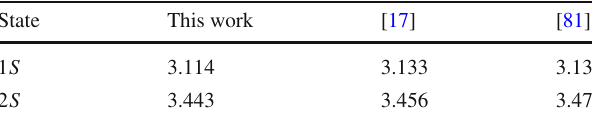
Table 3 Comparison of ground and first radially excited states for cc diquark masses. All results are in GeV unit